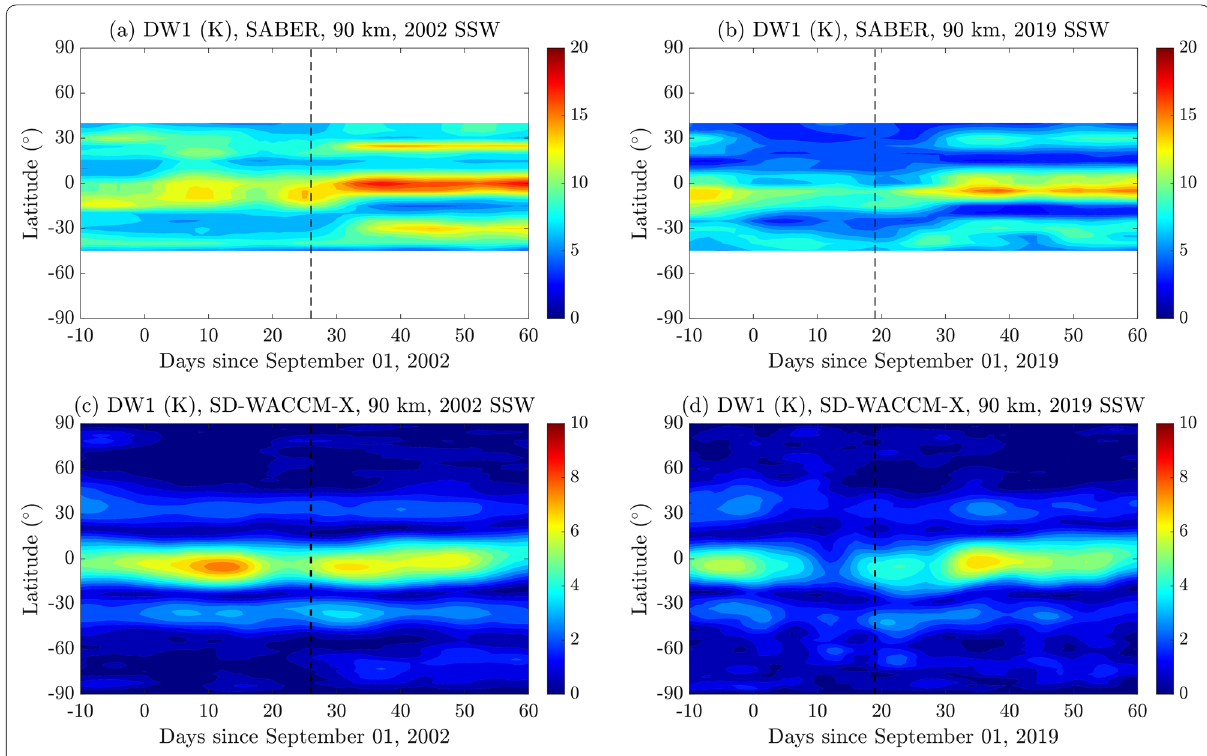
Fig. 4 Same as Fig. 3 except for ( a , c ) 2002 and ( b , d ) 2019 SH